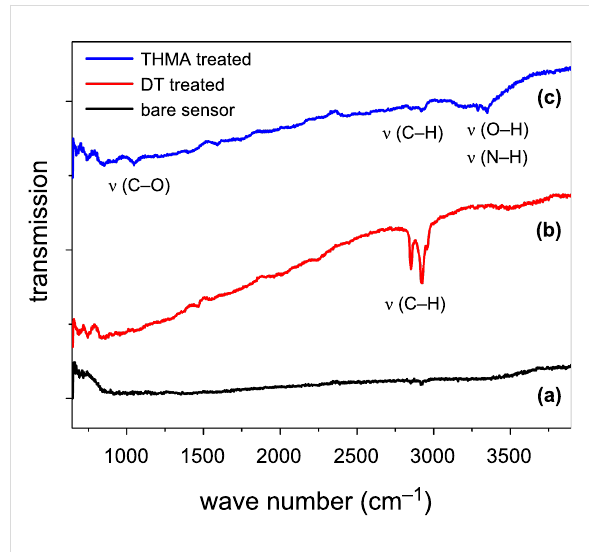
Figure 3: FTIR spectra of (a) pure ZnO nanowire sensor; (b) dode- canethiol-coated ZnO nanowire sensor; and (c) THMA-coated ZnO nanowire